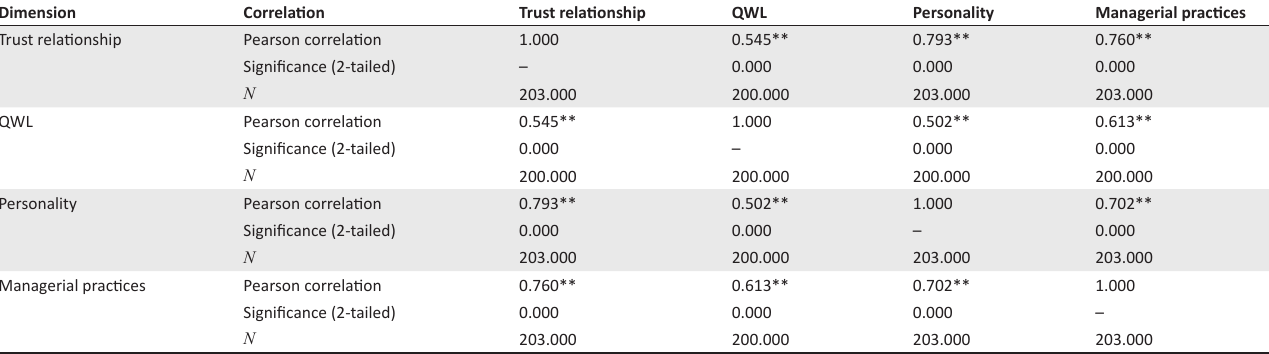
TABLE 6: Pearson product-moment correlations coefficients. Dimension Correlation Trust